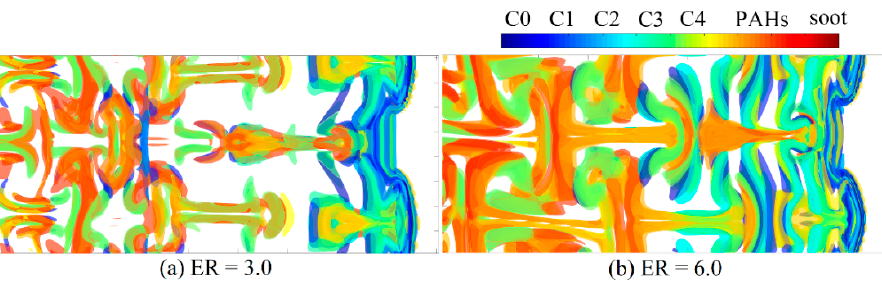
Figure 10. Detailed indication of local species gradient at a triple point. In acetylene-rich conditions, the initial process of the shock-induced reaction the main pathway is not the reaction of C 0 and C 1 but rather that of C 2 and C 4 species as vinylidene radical (H 2 CC), ethynyloxy radical (HCCO), acetaldehyde (CH 2 CHO), diacetylene (C 4 H 2